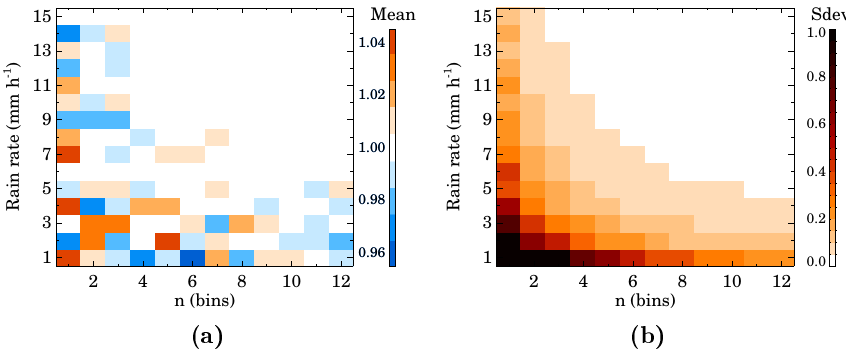
for homogeneous precipitation patterns, calculated from Monte 3